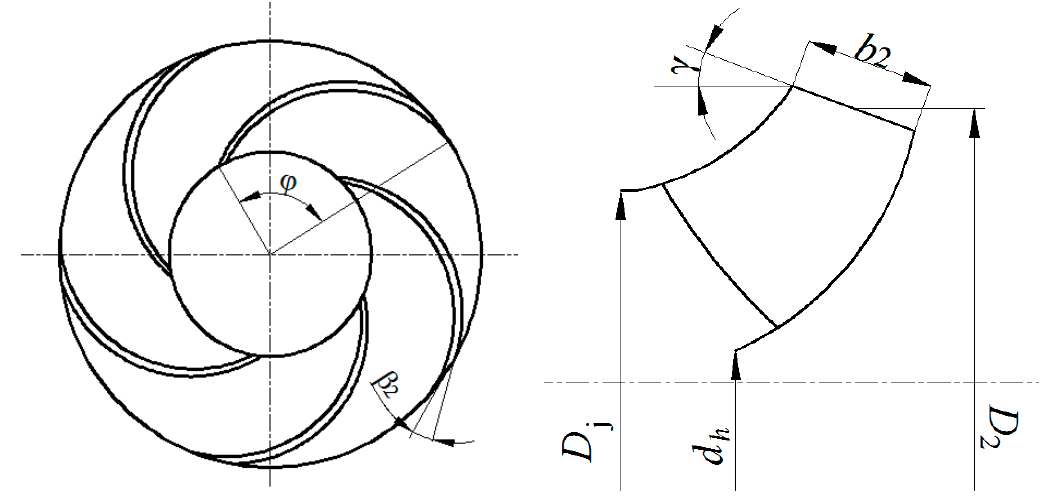
Figure 2. Schematic diagram of the main structural parameters of the impeller.